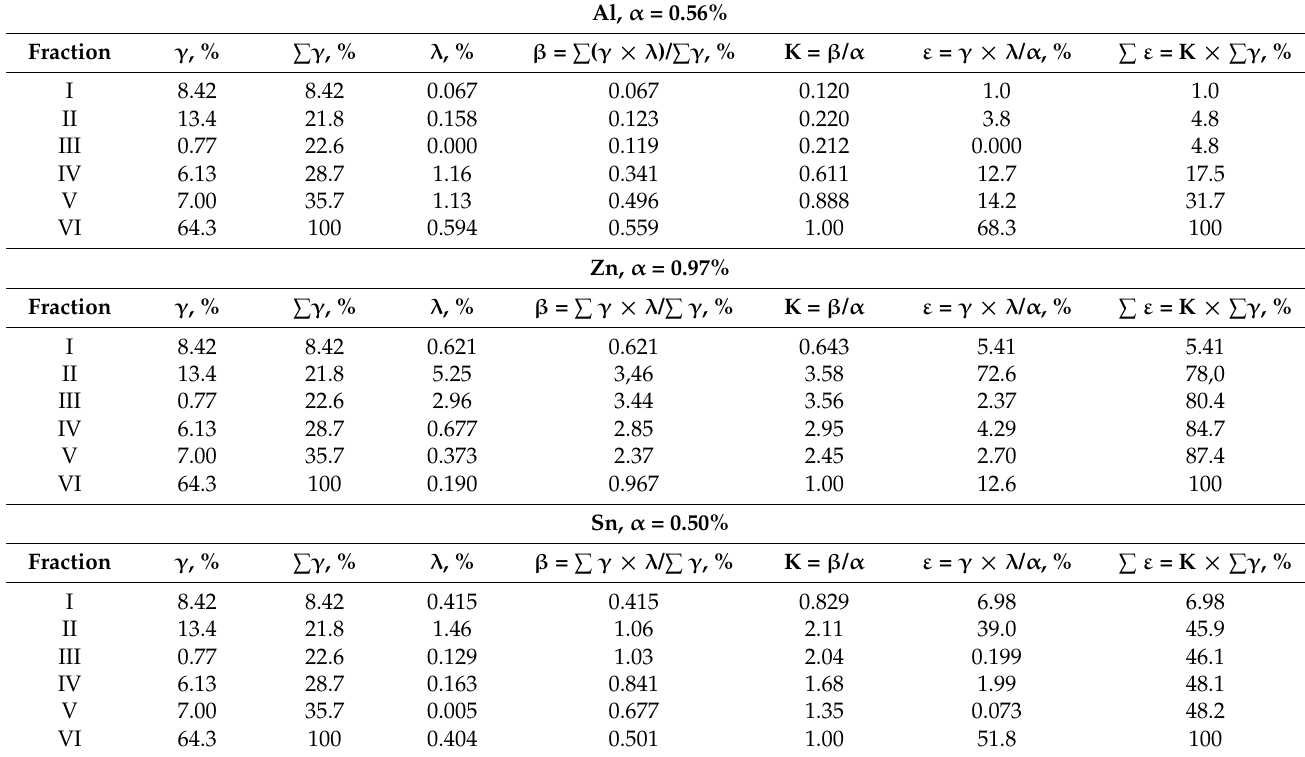
Table 11. The enrichment balance of the performed magnetic separation of aluminium, zinc, tin, gold and silver. Al, α =